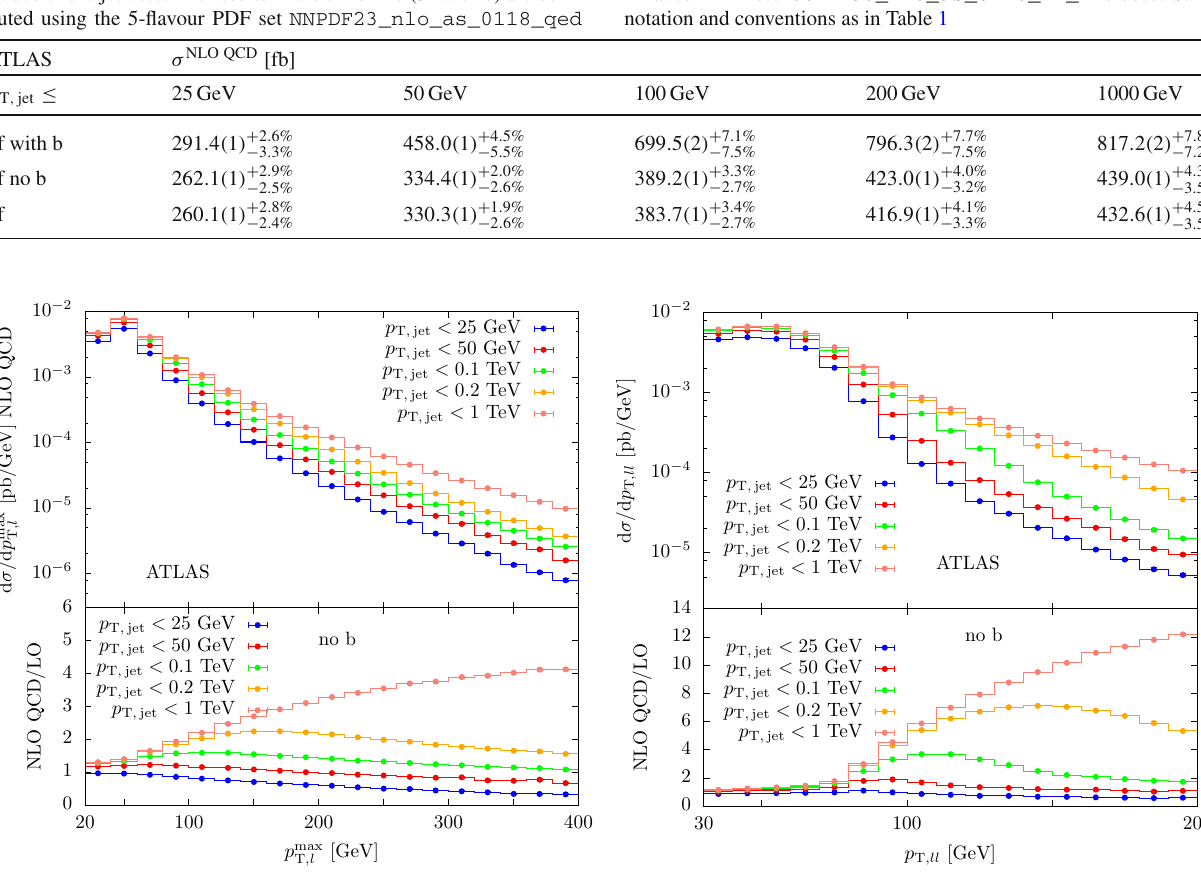
Fig. 1 Differential distribution in the transverse momentum of the condition in Eq. (4.4). Lower panels: ratio between the NLO QCD and the LO predictions (the same PDF set is used at LO and NLO QCD). hardest lepton ( p max ) and in the p T of the charged-lepton pair ( p T , ll ) √ T , l The contribution from initial-state b quarks is not s = 13TeV under the event for the process pp → e + ν e μ − ¯ ν μ at selections of Eq. (4.4) for different values of the jet p T entering the veto